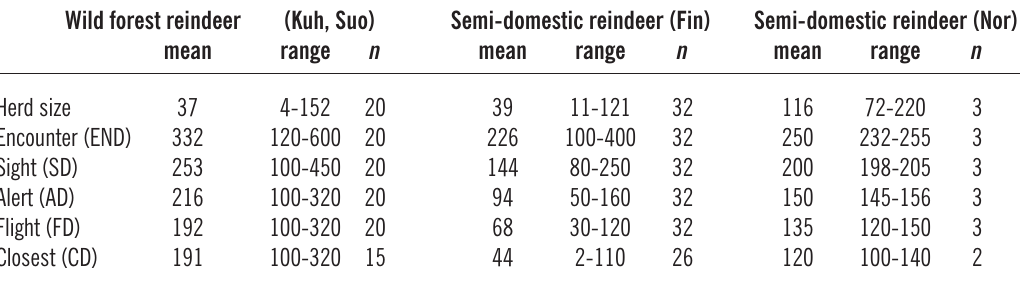
Table 3. Observed response distances of wild forest reindeer and semi-domestic reindeer in Finland and also of semi- domestic reindeer in Finnmark, Norway, when provoked by an observer on foot/snowshoes in 2010-12 (data pooled across years).